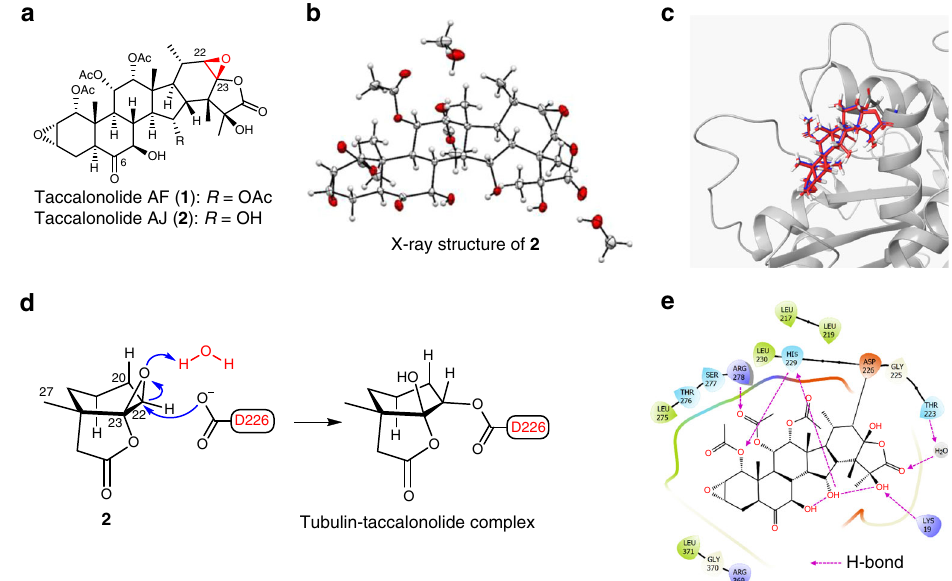
Fig. 1 The taccalonolide microtubule stabilizers covalently bind β -tubulin. a Structures of taccalonolides AF ( 1 ) and AJ ( 2 ) showing veri fi ed absolute con fi guration of the 22,23-epoxy moiety. b The ORTEP drawing of the single-crystal X-ray structure of 2 (CCDC ID: 1907790). c The published crystal structure (PDB ID: 5EZY) of 2 (red) bound to β -tubulin was superimposed with a model of 2 (blue) docked into β -tubulin (RMSD = 0.221) generated by CovDock. d The proposed reaction mechanism between 2 and β -tubulin D226. e The key tubulin residues that mediate the binding af fi nity of 2 in the docking model structure of c . The residues within a radius of 3.5 Å from 2 are displayed. The key H 2 O molecule bridging 2 and T223 was retained as it improved the accuracy of docking